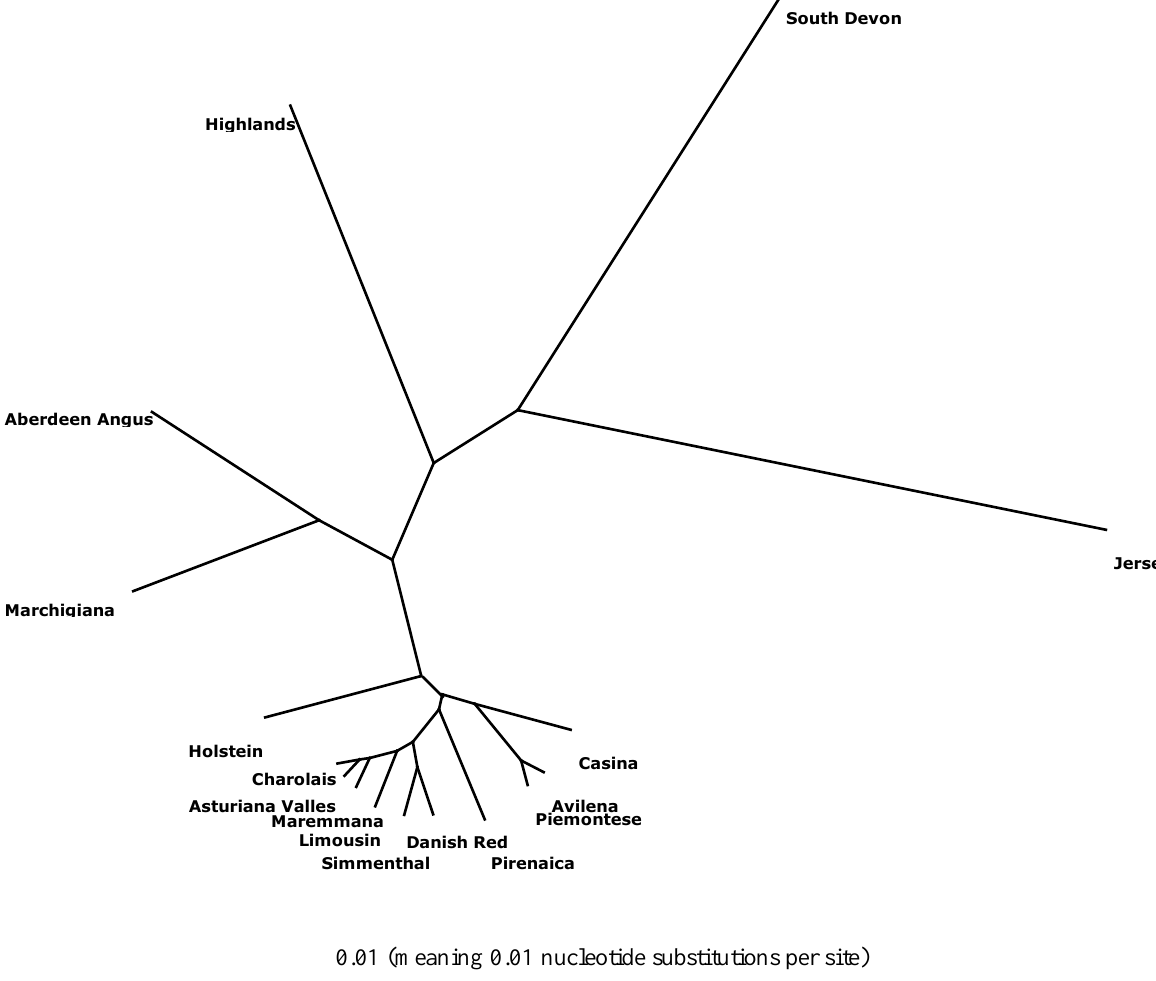
Figure 2. Phylogenetic relationship among the 16 breeds studied. The genetic distances were calculated from allelic frequencies by using Nei distances. The reconstruction was done with UPGMA (Sneath and Sokal,